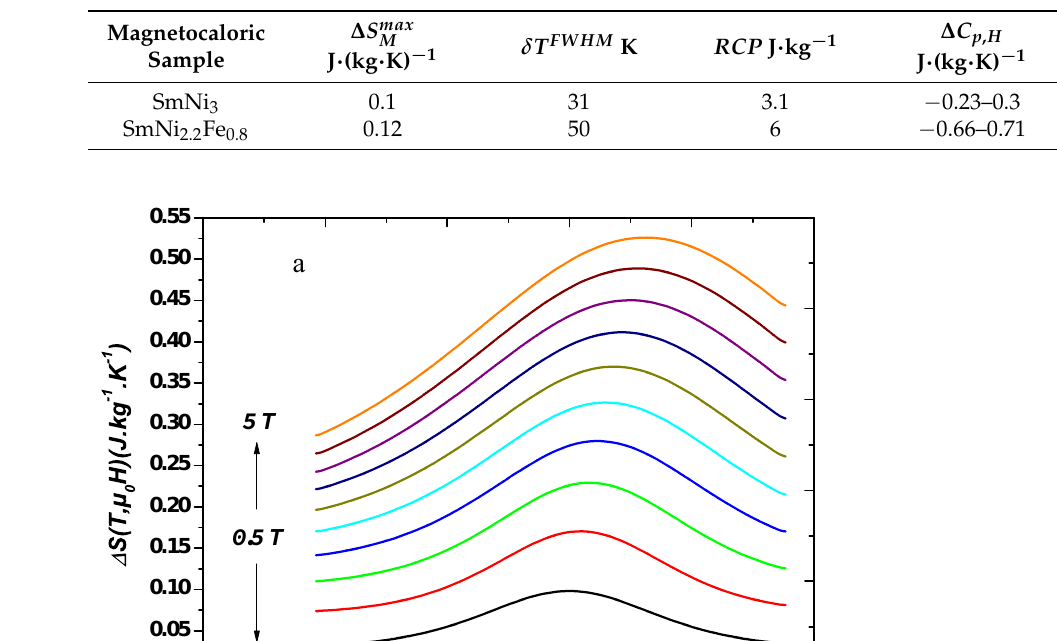
Table 2. ∆ S max , δ T FWHM , RCP and (minimum-maximum) of specific heat capacity for SmNi 3 and M SmNi 2.2 Fe 0.8 at low field µ 0 H = 0.5T.